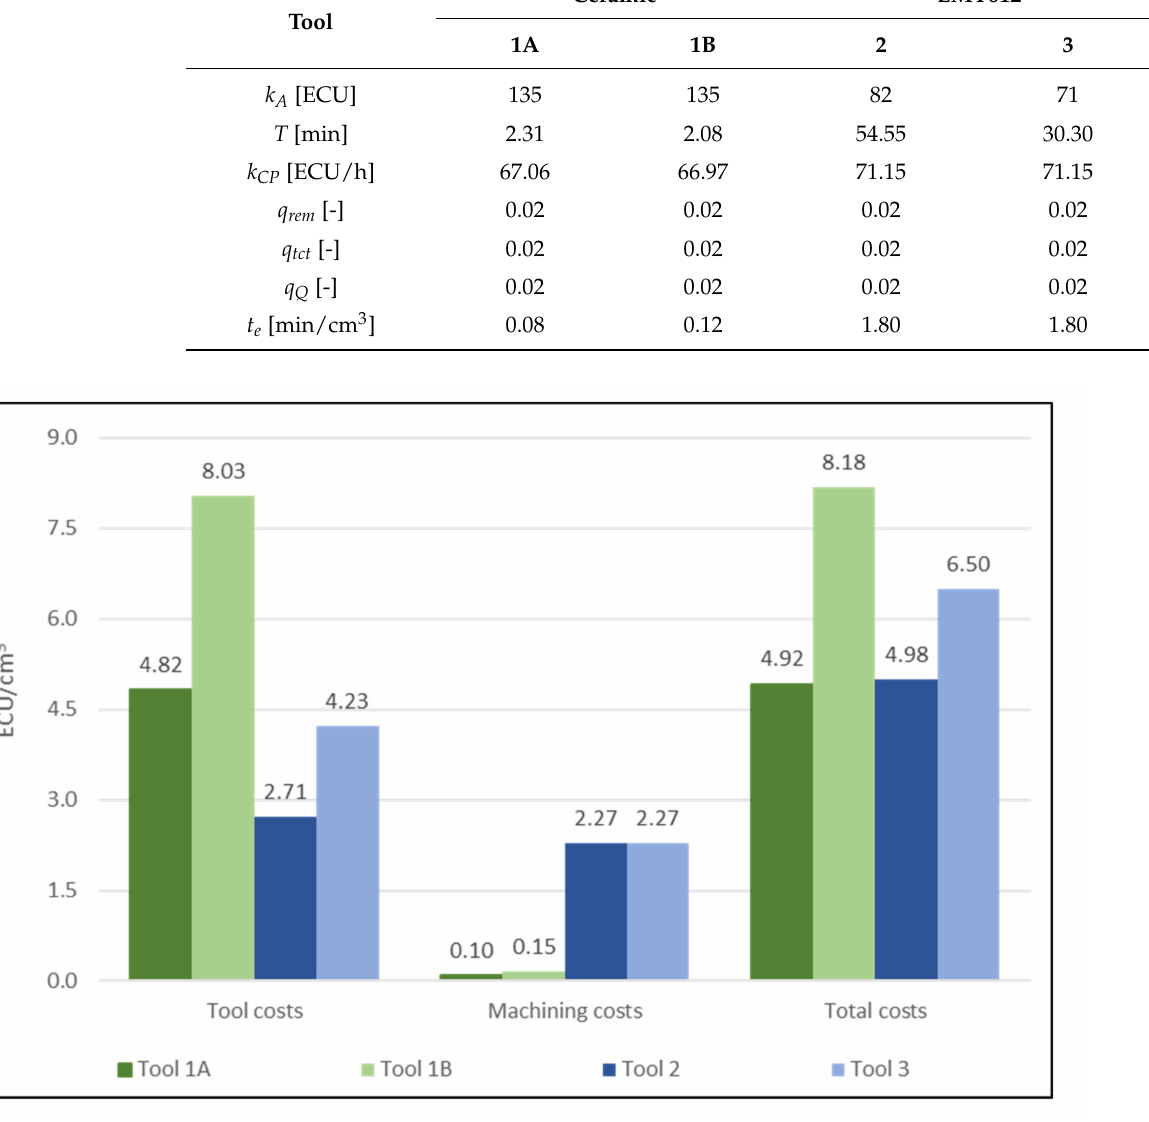
Figure 4. Running costs of each tool for 1 cm 3